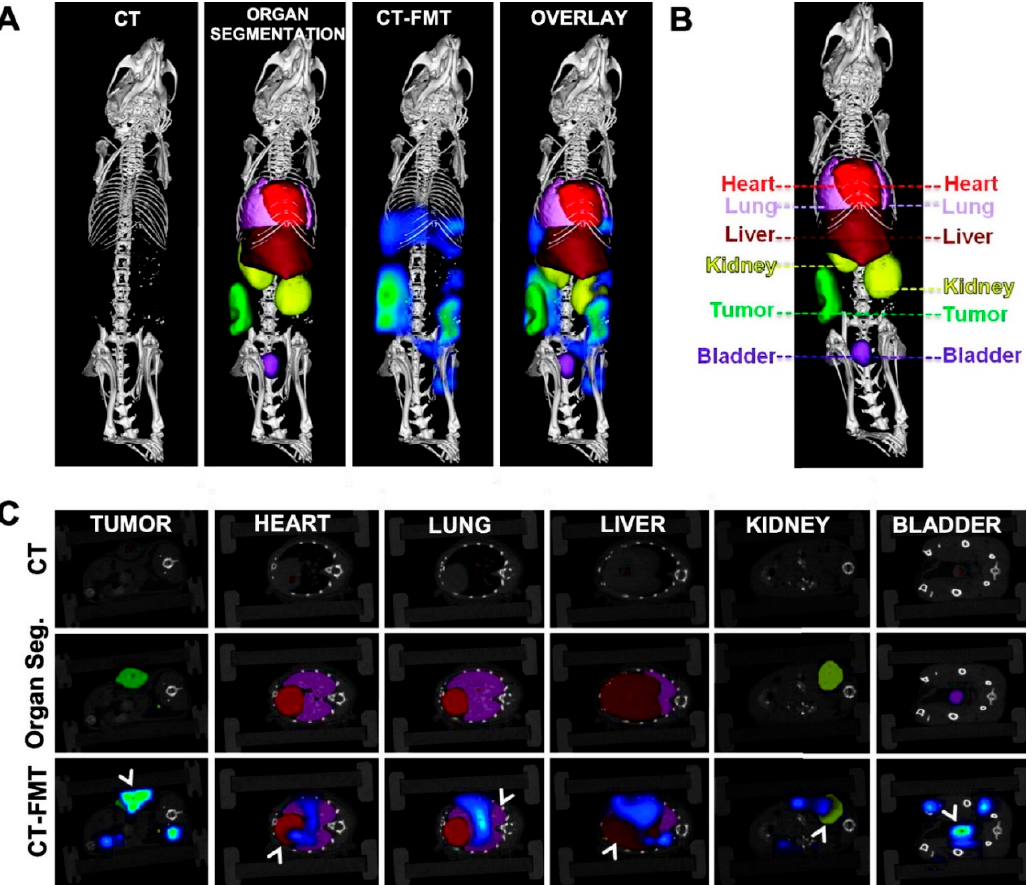
Figure 13. CT-based organ segmentation and hybrid CT-FMT imaging. ( A ) High-resolution µ CT scans of CT26 colon carcinoma-bearing nude mice, depicting highly electron-dense anatomical structures (i.e., bones), presegmented organs (cf. panel C), FMT-based biodistribution data overlaid on highly electron-dense anatomical structures, and FMT-based biodistribution data overlaid on presegmented organs. ( B , C ) Two-dimensional planes representing individual organs ( B ) and pHPMA-Dy750 accumulation in cross-sections of these organs ( C ), analyzed by fusing µ CT and FMT data sets. Reprinted with permission from [124], Copyright [2013], American Chemical Society.